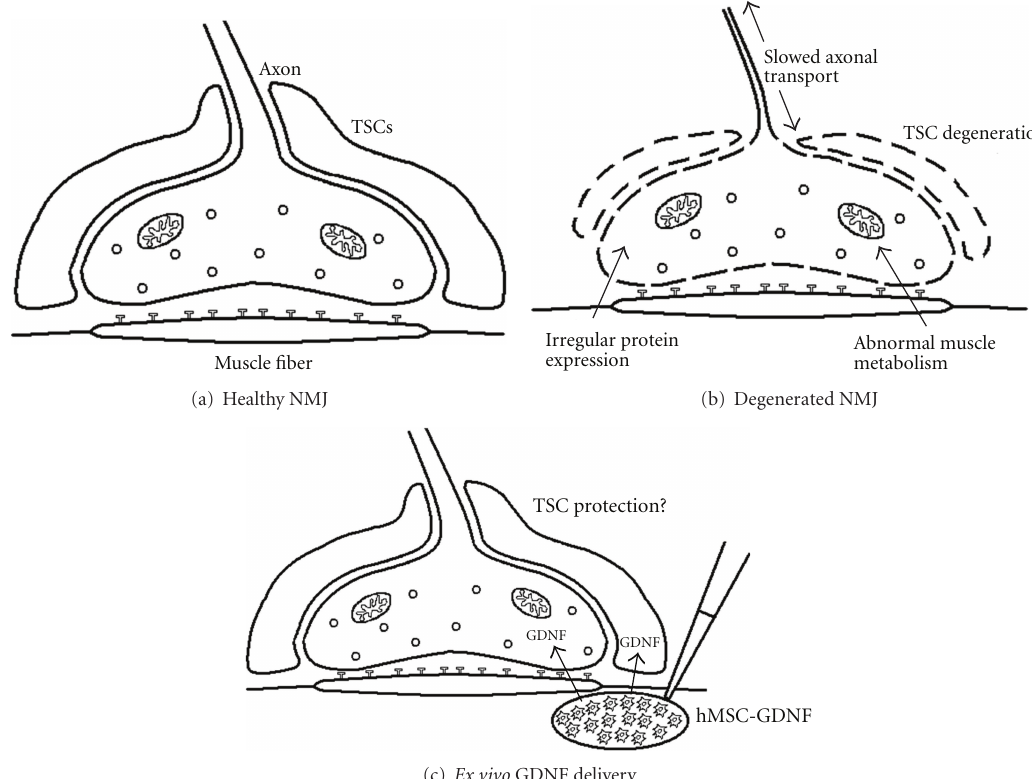
Figure 2: Schematic detailing NMJ degeneration and treatment. (a) A healthy, functioning NMJ, including TSCs and Ach receptors, is a vital point of communication between MNs in the spinal cord and muscle. (b) In ALS, NMJs begin to degenerate due to a number of pathologies, including disrupted axonal transport and irregular mitochondrial metabolism. NMJ degeneration occurs long before MN degeneration in the spinal cord, preceding clinical symptoms. (c) Ex vivo delivery of GDNF to NMJ via hMSC-GDNF may help to rescue TSCs from degenerative processes, thereby, delaying or preventing degeneration of the NMJ as a